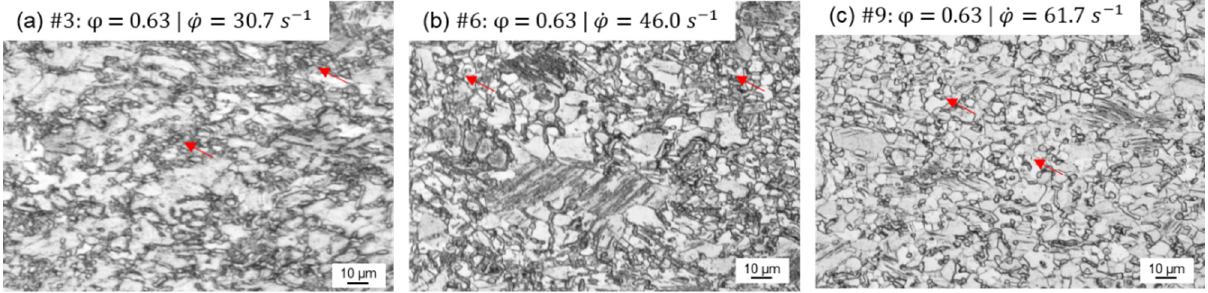
Figure 3. Optical micrographs of the as-rolled WZ73 magnesium alloy produced with an equivalent strain of 0.63 and different equivalent strain rates: ( a ) sample #3, ( b ) sample #6 and ( c ) sample #9 (red arrows mark recrystallized areas).